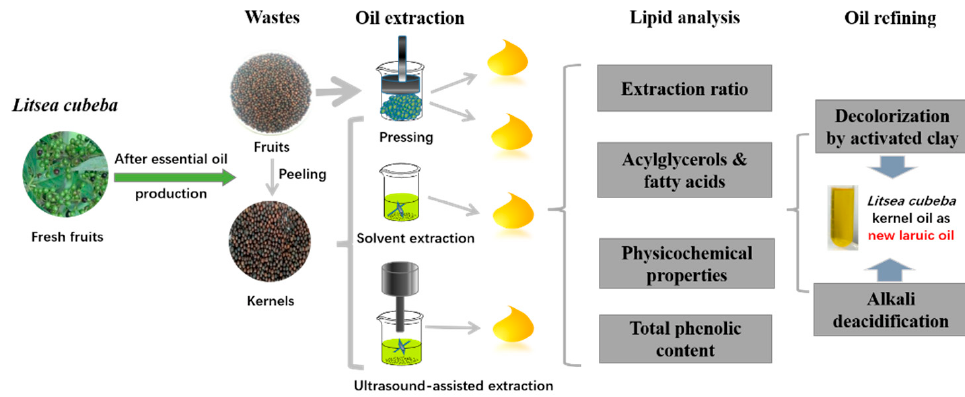
Figure 2. Schematic experimental design.